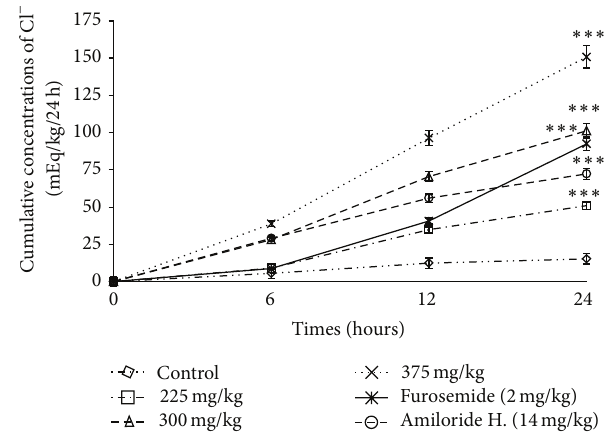
Figure 5: Effects of the aqueous extract of F. glumosa on the cumulative Cl − excretion. Values are means ± SEM, 𝑛 = 5 , ∗ ∗ ∗ < 0.001 , significant difference compared to the control.